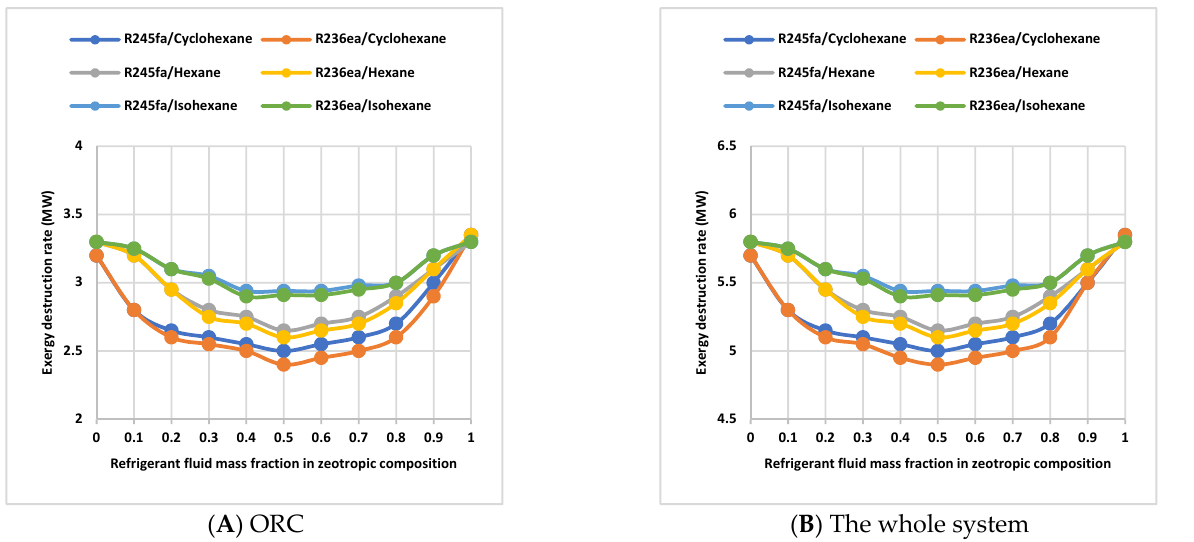
Figure 6. The destructive rate of exergy in the whole system and the ORC to the mass fraction of refrigerants in the zeotropic composition.